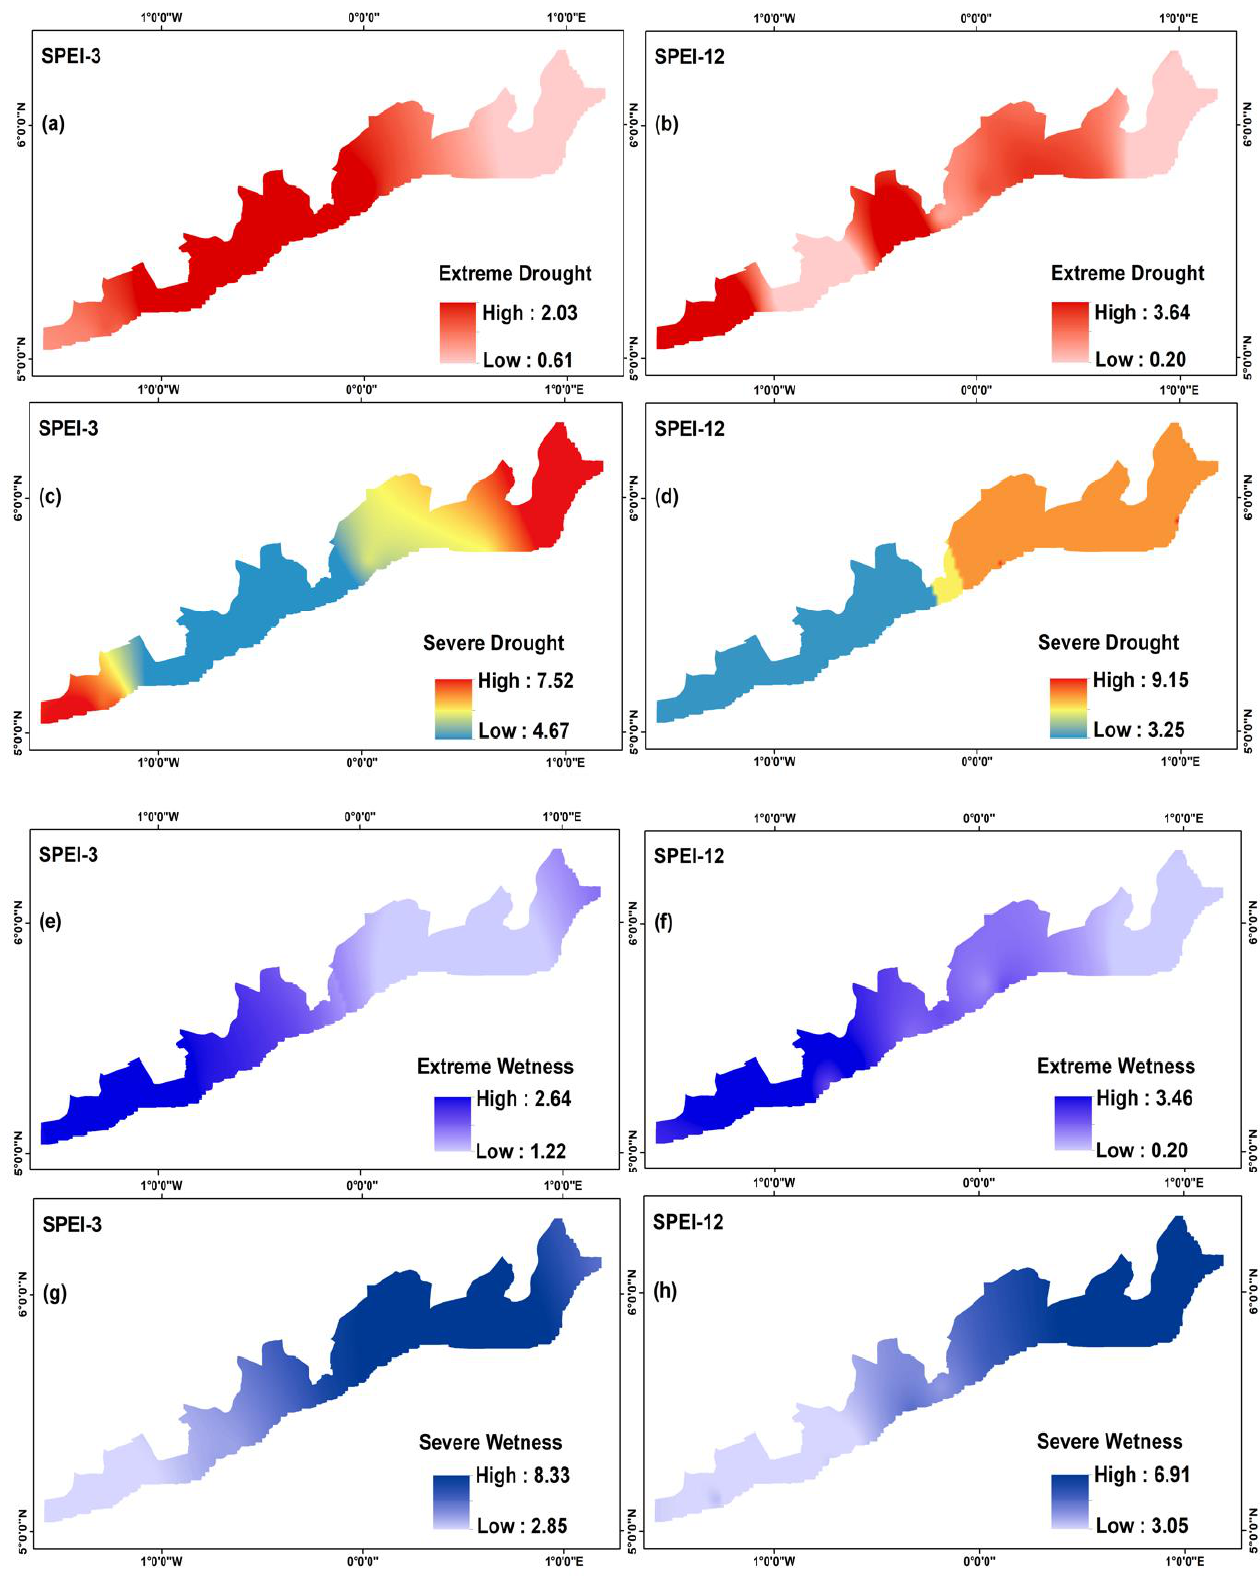
Figure 5. Spatial distribution of the average values for SPEI-3 and SPEI-12 for extreme drought ( a , b ), severe drought ( c , d ), extreme wetness ( e , f ), and severe wetness ( g , h ) events in the coastal Savannah agroecological zone of Ghana from 1981 to